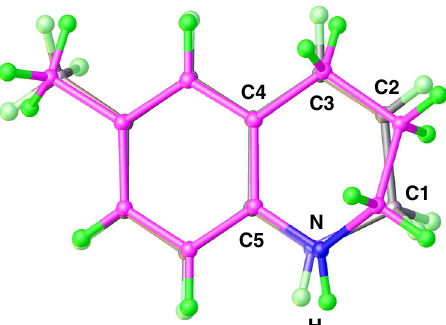
Fig. 3 Superposition of 3u (gray) with 4u (magenta). Selected bond distances (Å) for 4u : N1-C1, 1.452(3); C1-C2, 1.514(3); C2-C3, 1.527(3); C5-N1, 1.398